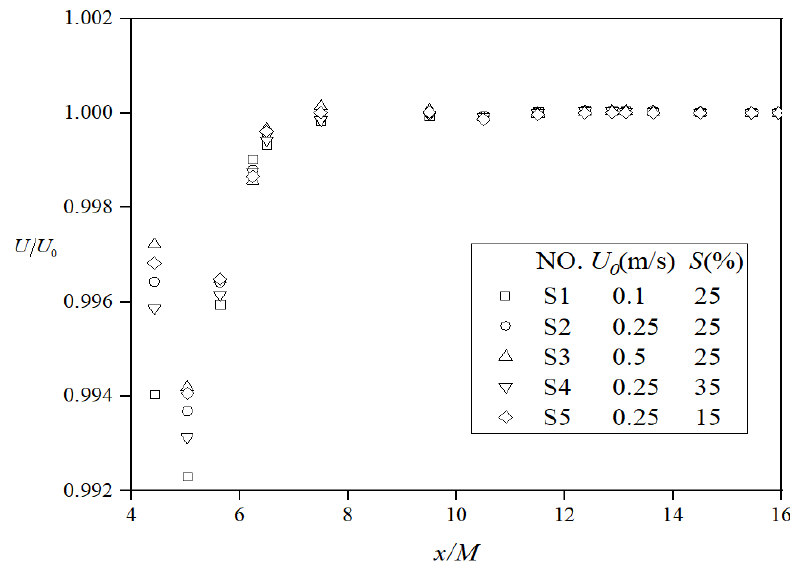
Figure 6. The flow velocity reduction factor U/U 0 at different downstream locations in the simula- tion